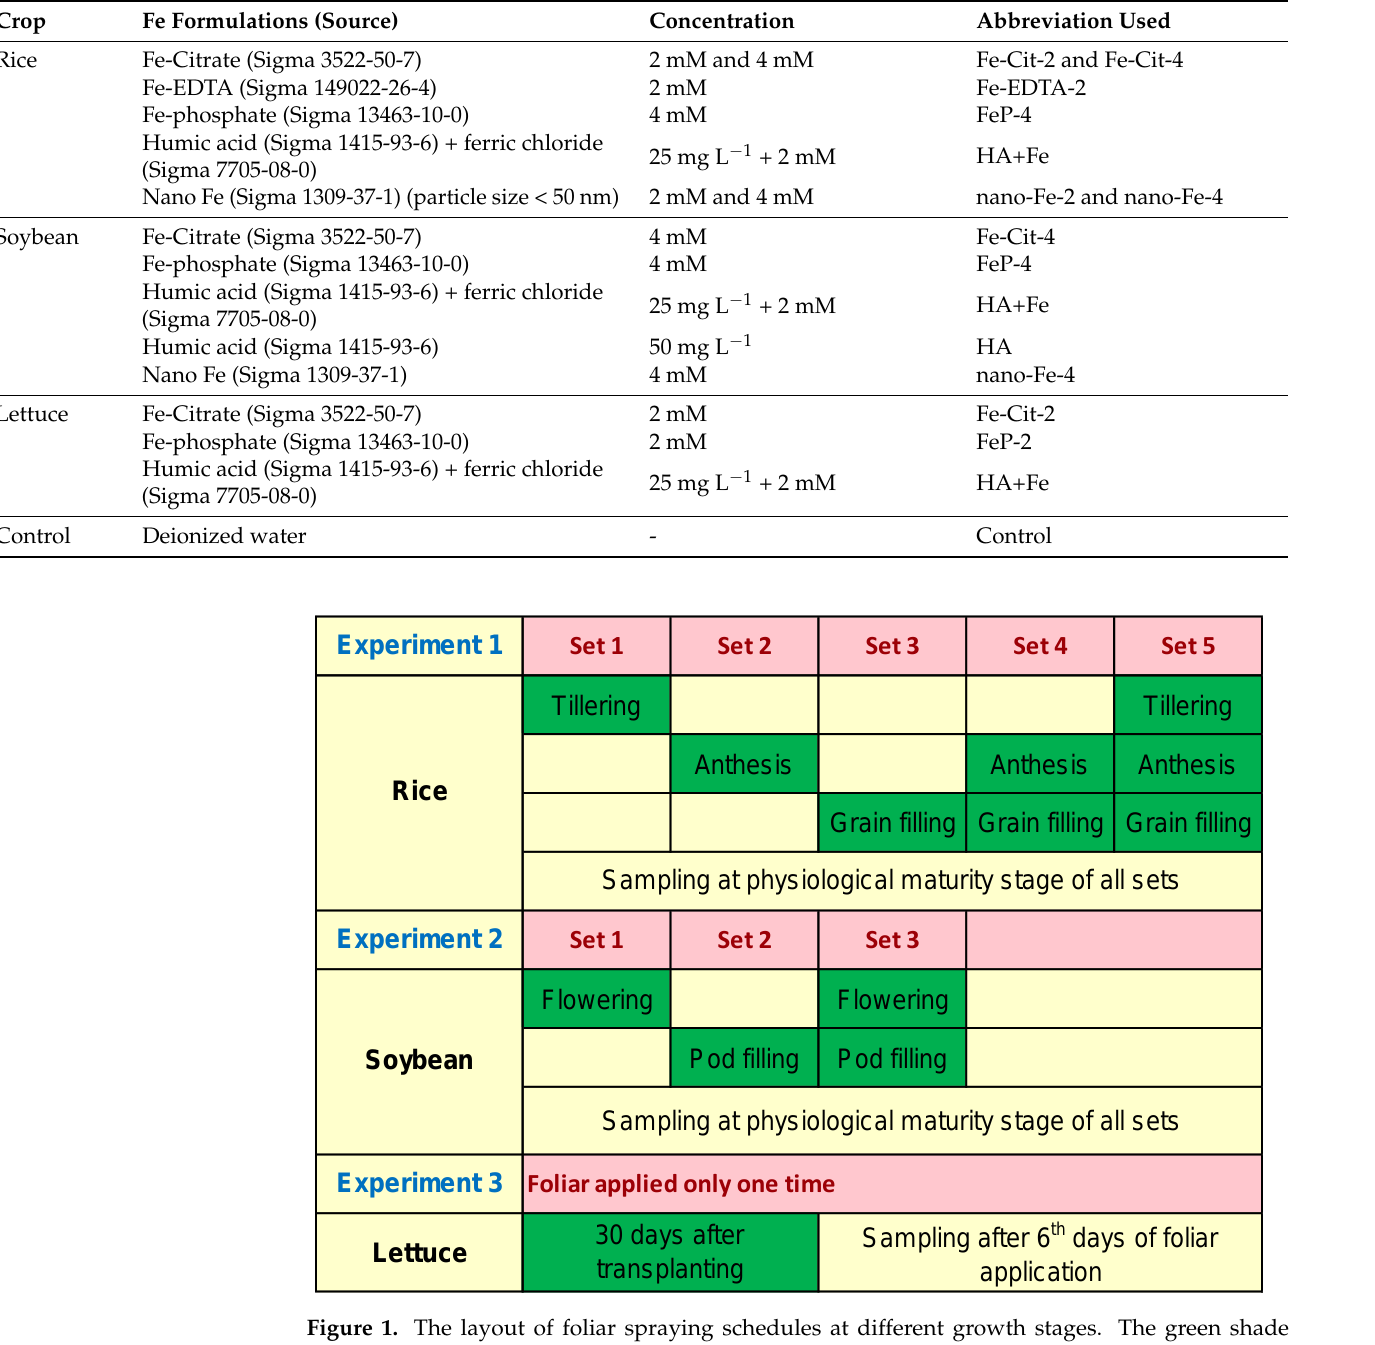
Table 1. Details of Fe formulations applied as foliar spray on rice, soybean, and lettuce in different growth stages.